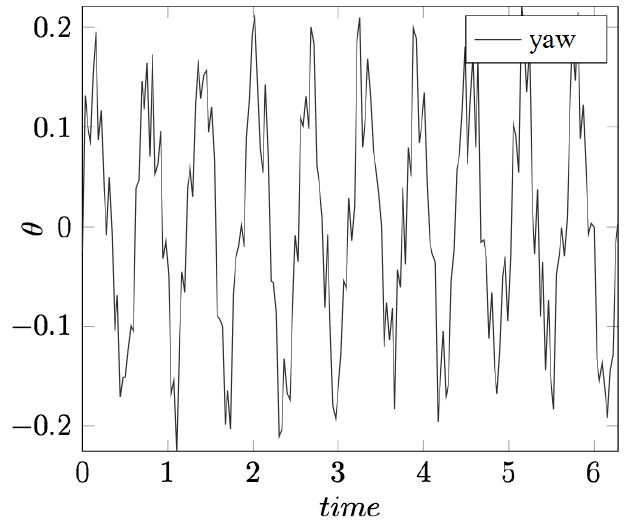
Figure 13. Yaw evolution. Table 1. Simulation showing the correction of orbital elements using thruster